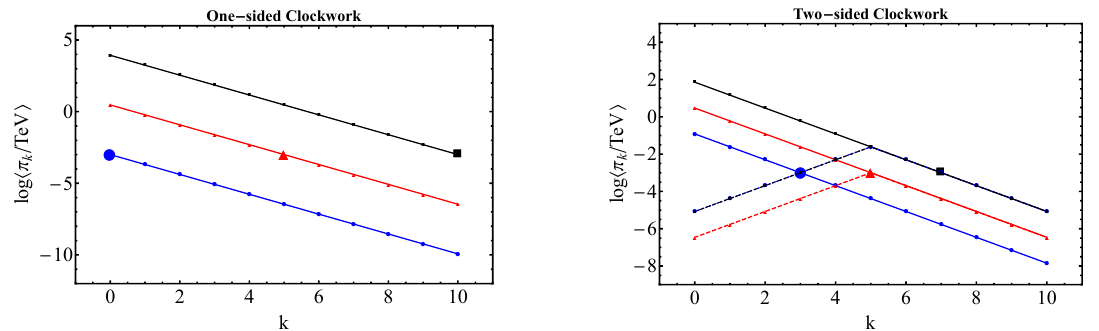
Figure 1 . The left panel shows an illustrative example of the variation of log h (cid:25) k = TeV i as a function of the site k for a one-sided clockwork setup with total 11 sites (i.e. N = 10). Three di(cid:11)erent lines correspond to the soft breaking potential V soft , added at sites k = 0 (blue), k = 5 (red) and k = 10 (black) respectively. The bigger bullets also indicate the site of the breaking term. Notice that, for all three lines, the largest vev is located at site k = 0 and smallest at k = 10, irrespective of the site of breaking. The two-sided clockwork setup is shown in the right panel where pivot point is at the middle site k = 5, while the soft breaking terms are added at k = 3 (blue), k = 5 (red) and k = 7(black). Three solid lines correspond to the one-sided clockwork while the dashed lines shows the two-sided case. Notice that, for all three lines, the largest vev is located at site k = 5 and smallest at k = 0 and k = 10, irrespective of the site of breaking. In this case, soft breaking at k = 3 and k = 7 gives rise to same structure of vev